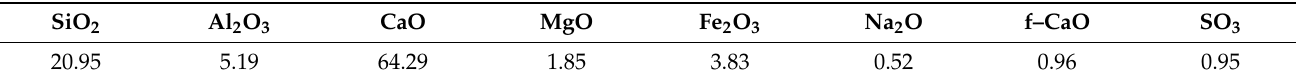
Table 1. Portland cement main chemical composition (wt. %).